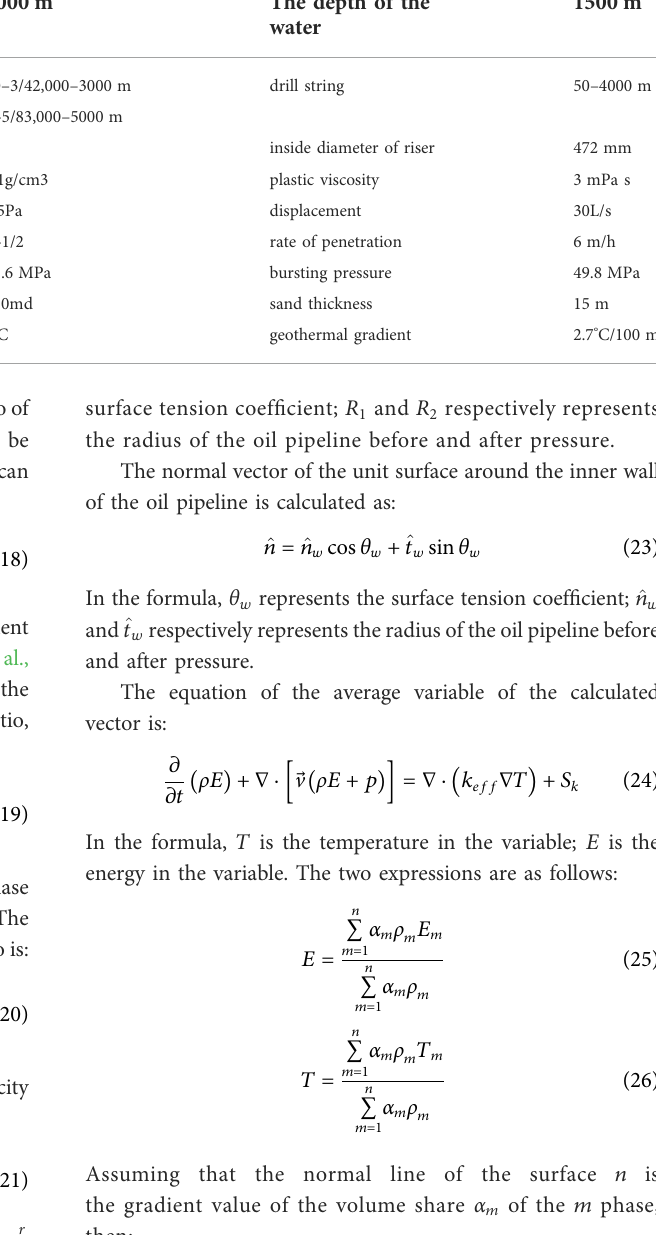
TABLE 1 Basic experimental data of oil pipeline